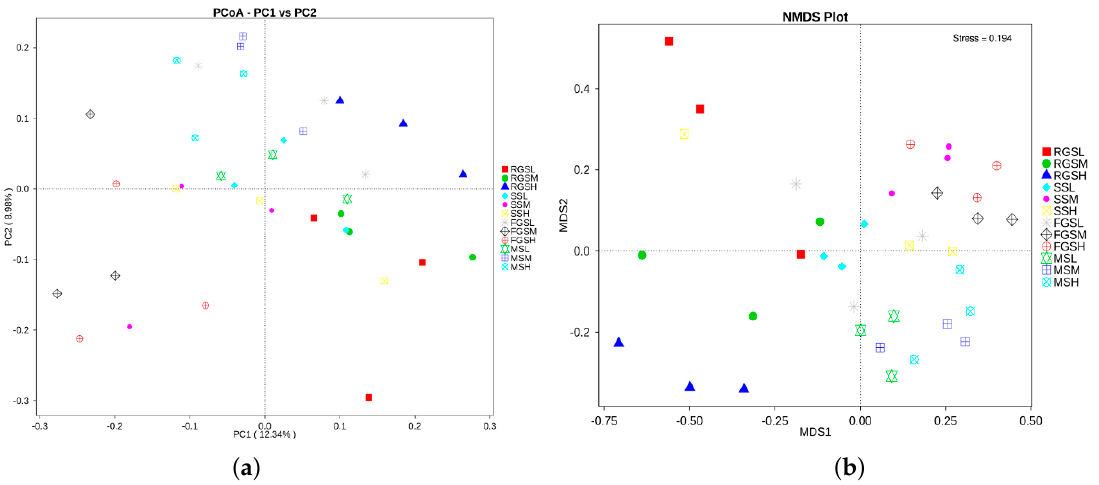
Figure 6. The beta diversity indices of different samples of Nicotiana tabacum ( a ) Principal coordinate analysis (PCoA) based on the weighted and unweighted Unifrac distances. ( b ) NMDS analysis results based on operational taxonomic unit (OTU) levels.